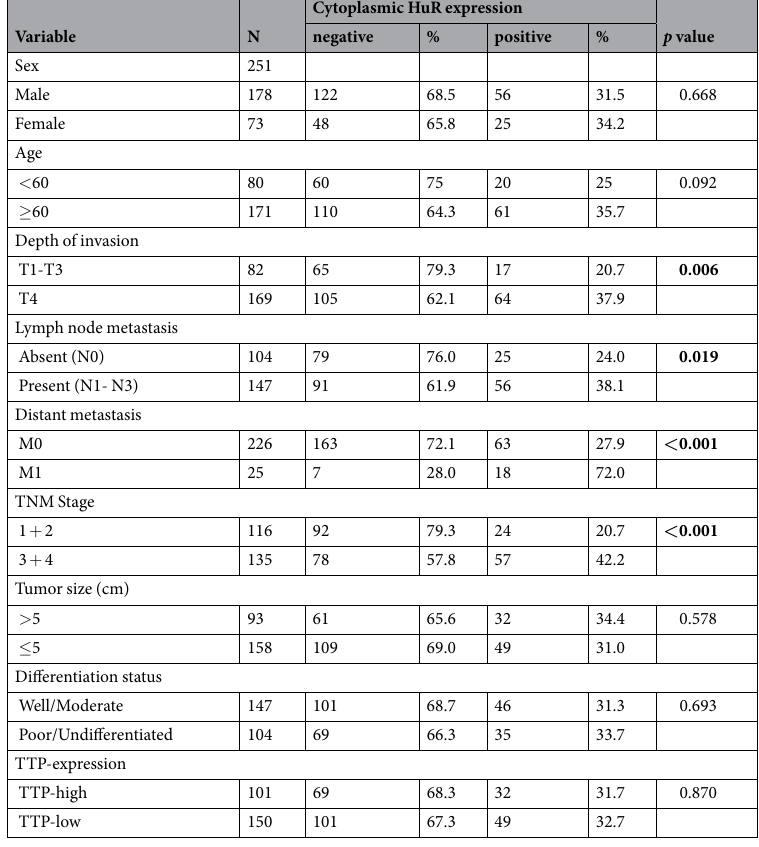
Table 2. The correlations between cytoplasmic HuR expression and the clinical features of GC patients. P value < 0.05 was indicated in